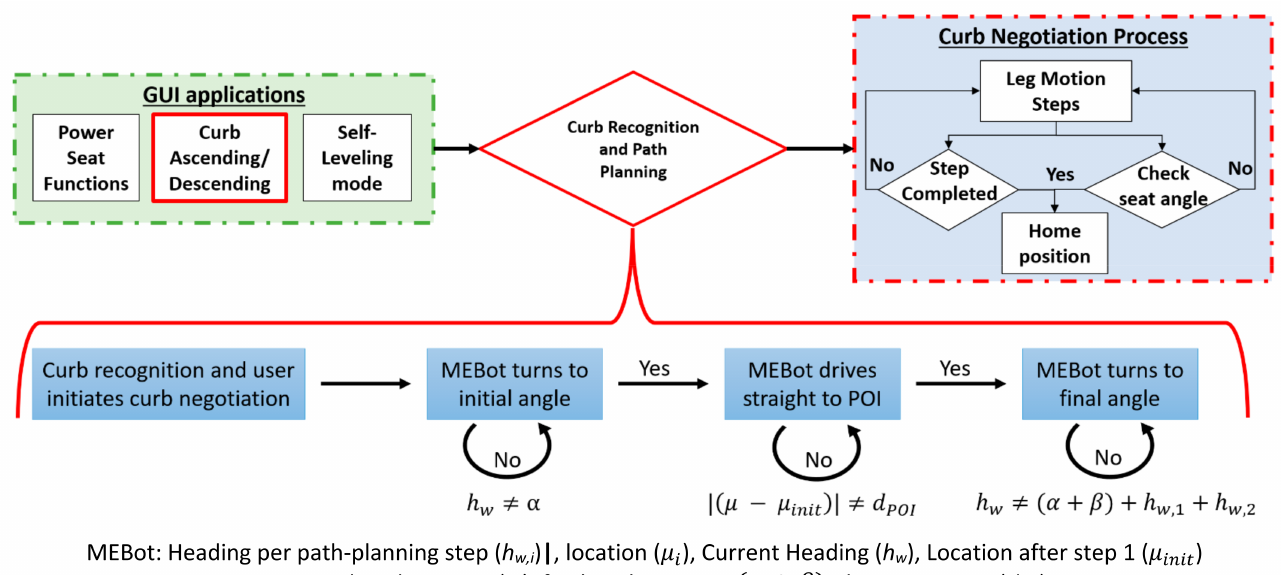
Figure 8. Current curb negotiation process of the MEBot (top). Improved process using CRN system